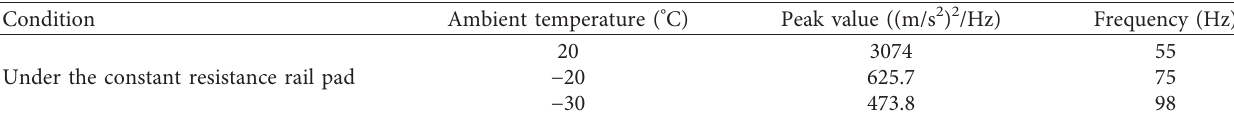
Table 8: Power spectrum peak and peak frequency of the